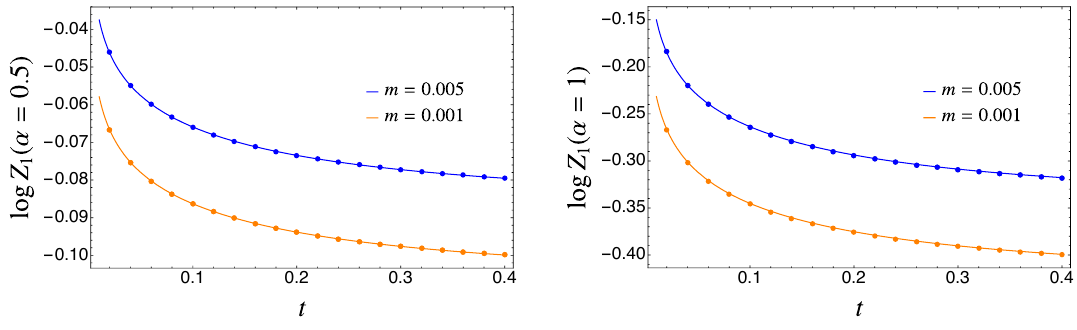
Figure 2 . Leading scaling behaviour of the charged R(cid:19)enyi entropies with the insertion of a (cid:13)ux (cid:11) . The numerical results (symbols) for two di(cid:11)erent values of (cid:11) and masses m are reported as functions of t = m‘ when n = 1. The data match well the prediction in eq. (4.12) (solid lines) which includes lattice corrections as explained in the